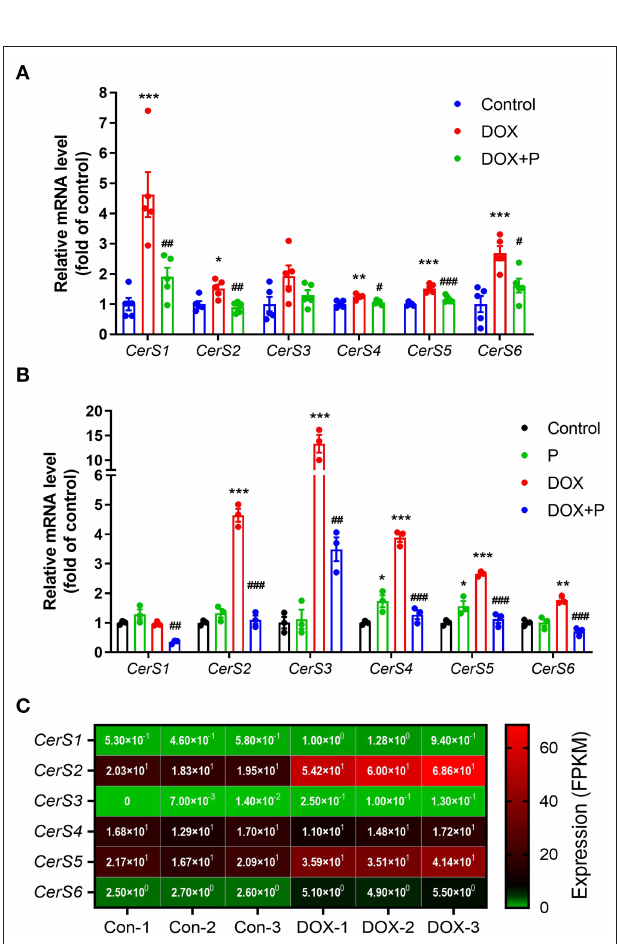
FIGURE 6 | Periplocymarin regulated the expression of enzymes involved in ceramides metabolism. (A) CerS1-6 messenger RNA (mRNA) expression in the heart tissues was measured by real-time PCR. Data are presented as mean ± SEM; n = 5, * p < 0.05, ** p < 0.01, *** p < 0.001 vs. control; # p < 0.05, ## p <0.01, ### p <0.001 vs. DOX. (B) CerS1-6 mRNA expression in the primary cardiomyocytes was measured by real-time PCR. Data are presented as mean ± SEM; n = 3, * p < 0.05, ** p < 0.01, *** p < 0.001 vs. control; ## p < 0.01, ### p < 0.001 vs. DOX. (C) The expression of CerS1-6 in the RNA sequencing data